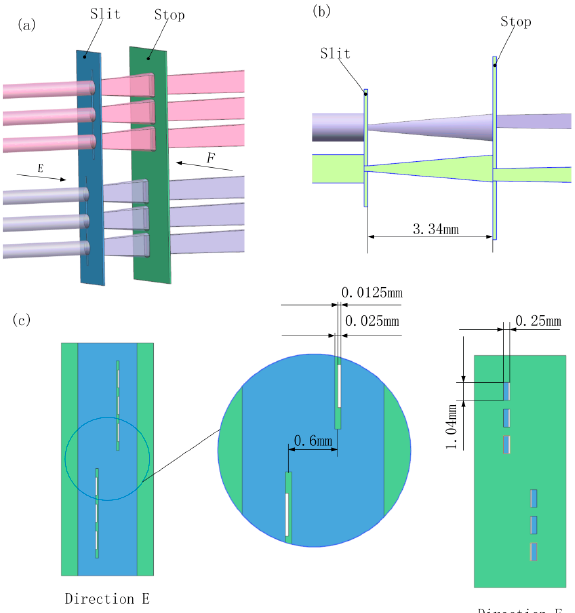
Figure 12. The positional relationship between the slit and the stop, which is one of the key factors to ensure that the spectrum does not alias on the image plane of the detector: ( a ) Schematic diagram of location relationship; ( b ) Schematic diagram of distance relationship; ( c ) Schematic diagram of dimensional relationship.